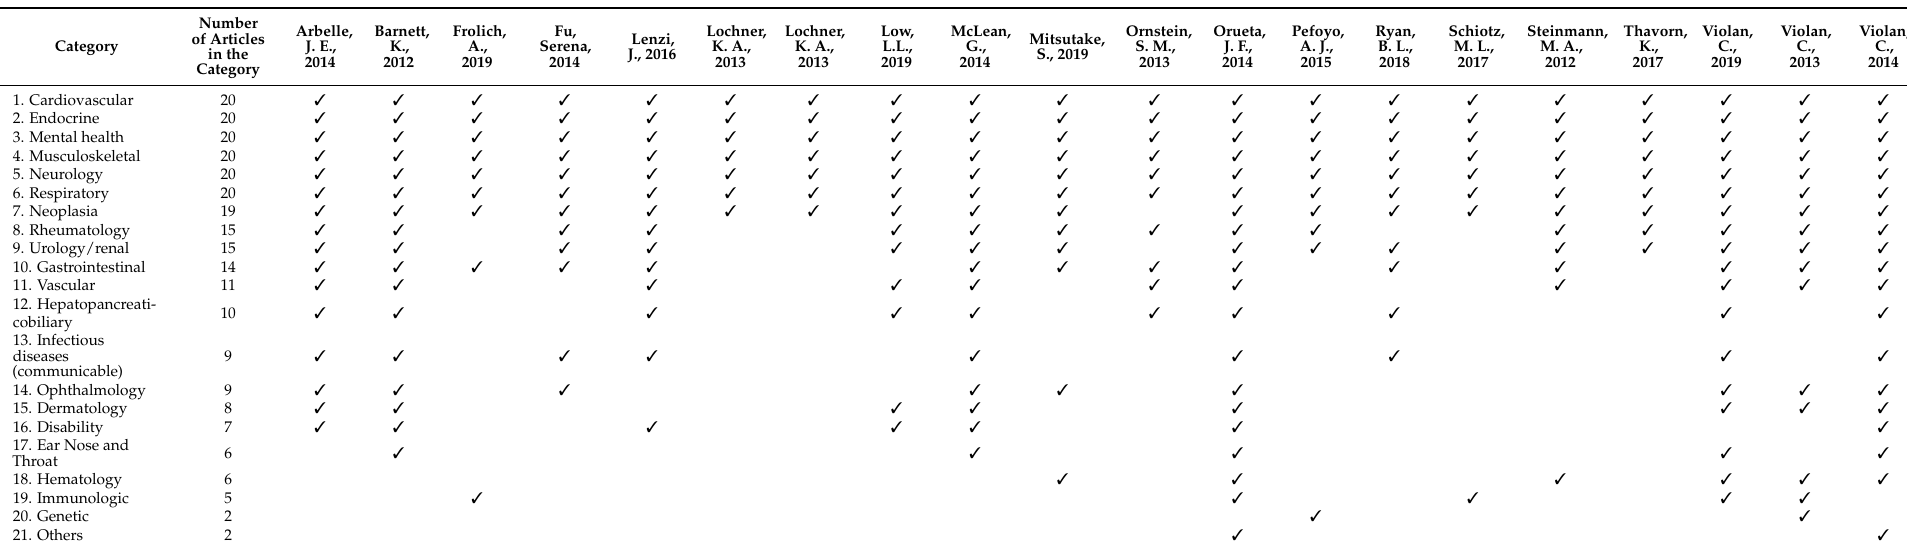
Table 2. Categories of